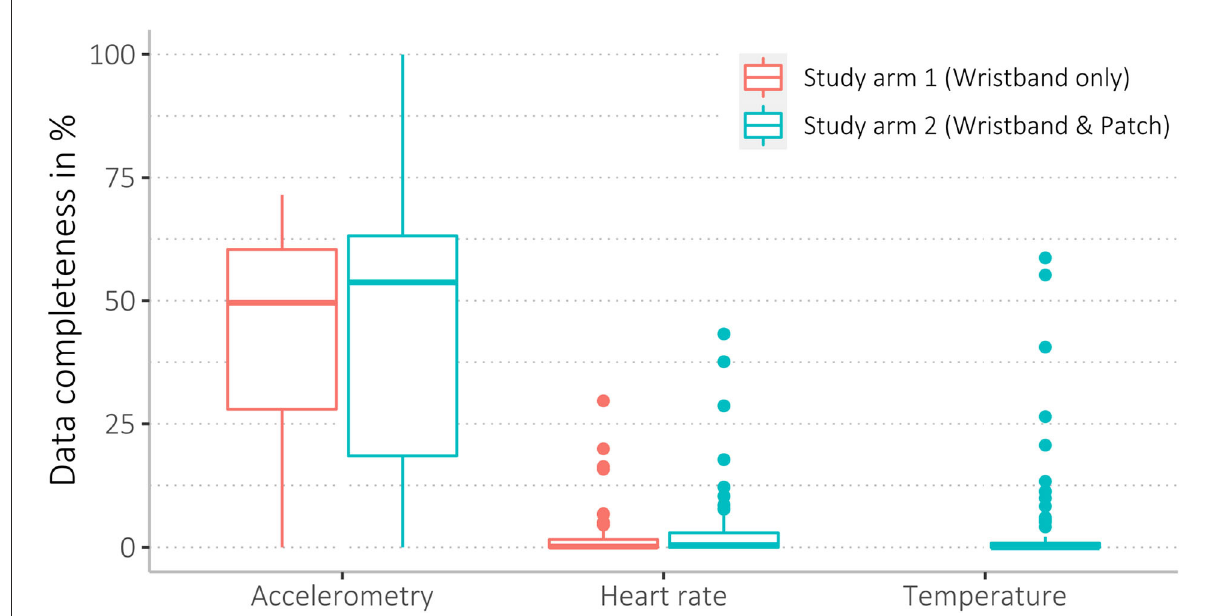
FIGURE5 Data completeness of study arms. As the participants from study arm 1 only wore the WPHR, there is no temperature data for this group.